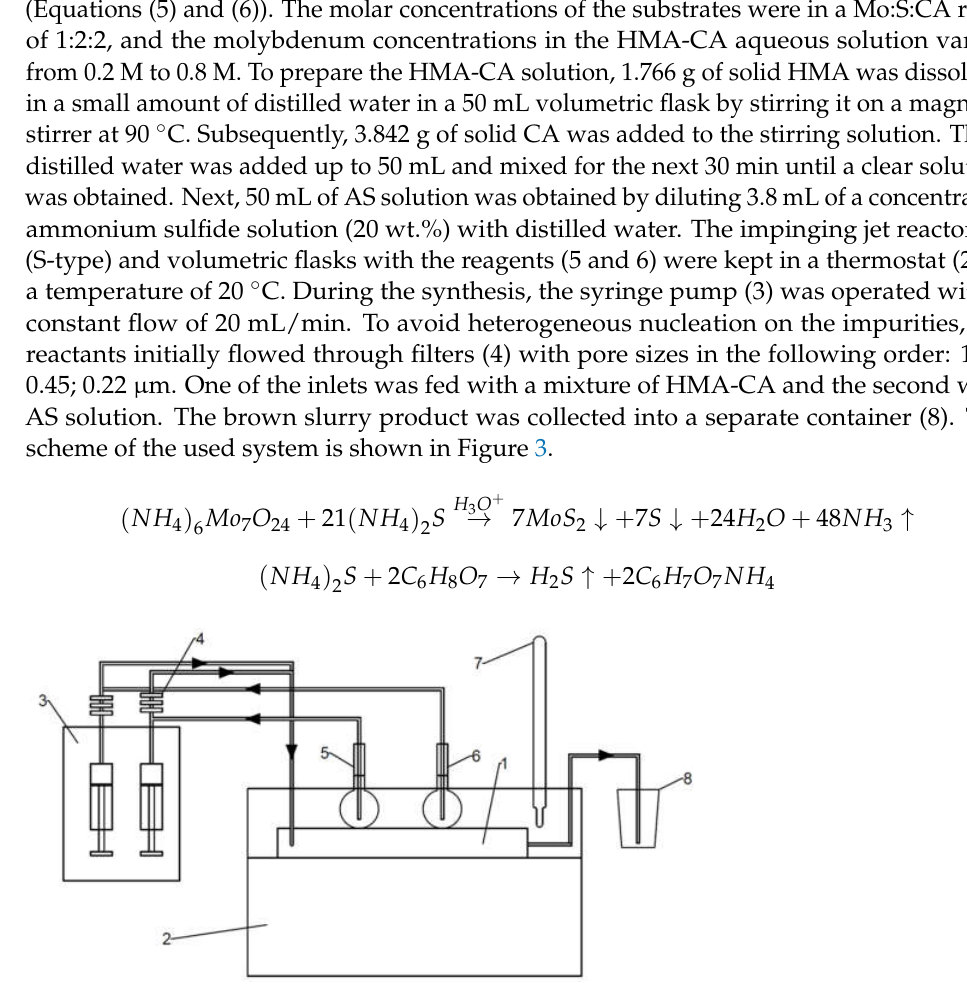
Table 1. Physicochemical parameters of reagents used [27].